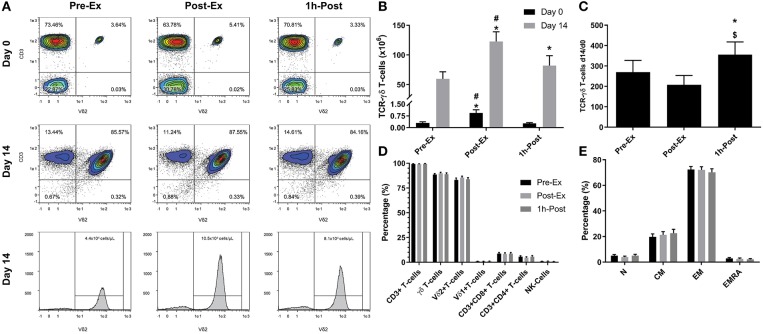
Exercise augments the ex vivo expansion of Vγ9δ2 T-cells: (A) representative flow cytometry contour plots and histograms showing the effect of exercise on the proportions of Vγ9δ2 T-cells among total PBMCs at Day 0 and after 14-days expansion with ZOL+IL-2. Histogram events are adjusted to reflect the total number of cells isolated per μI of cell culture supernatant. (B) The total number of TCR-γδ cells in 1 × 106 PBMCs isolated before (Pre-Ex), immediately after (Post-Ex), and 1 h after exercise (1 h-Post) at Day 0, and the total number of TCR-γδ T-cells generated in the expanded cell products after 14-days stimulation with ZOL+IL-2. Significant differences were only determined within expansion period (Day 0 or 14) and not between. (C) The number of TCR-γδ cells generated at Day 14 divided by the number of TCR-γδ cells in the PBMC fractions at Day 0. (D) The cellular composition of the expanded TCR-γδ T-cell products at Day 14. (E) The proportions of naïve (N), central memory (CM), effector memory (EM), and CD45RA+ effector memory (EMRA) cells among total TCR-γδ T-cells. Values are mean ± SE (n = 14). Differences from Pre-Ex, Post-Ex, and 1 h-Post are indicated by *, $, and #, respectively (p < 0.05).